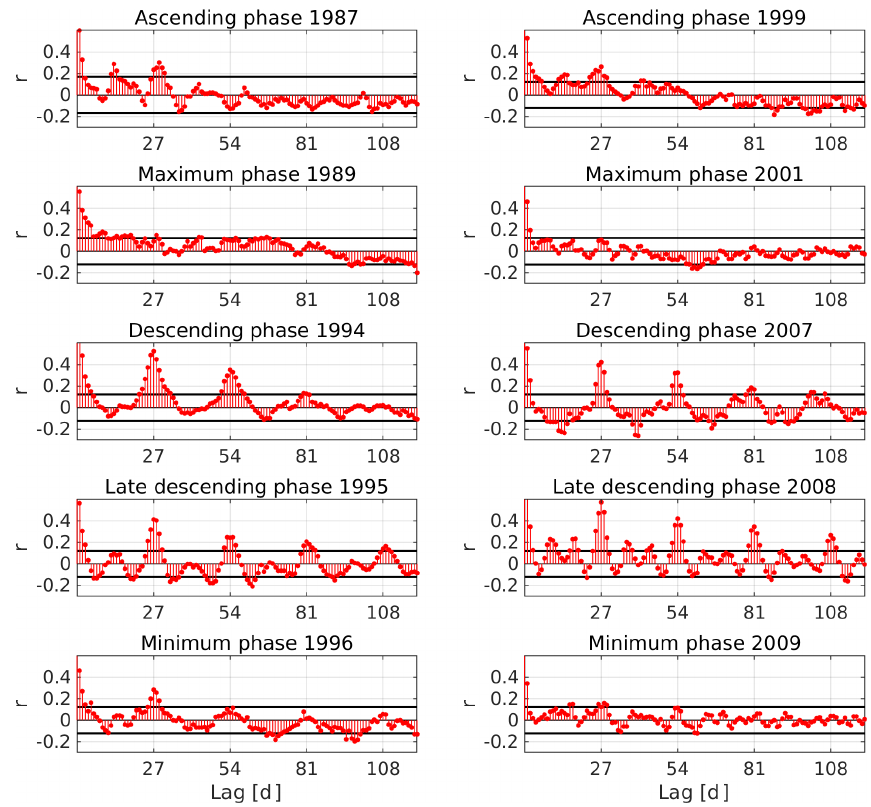
Figure 3. Autocorrelation functions (ACFs) of Pc5 power for different phases of the SC 22 (a) and 23 (b) as a function of lag in days. The horizontal black lines are the critical values of correlation